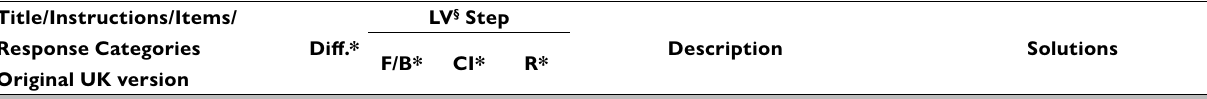
Table 3. Most problematic PKU-QOL translation issues classified by version (Children, Adolescents, Adults and Parents) and by type of difficulty (Diff.) – Cultural (C), Idiomatic (I), Semantic (S) and Syntactic